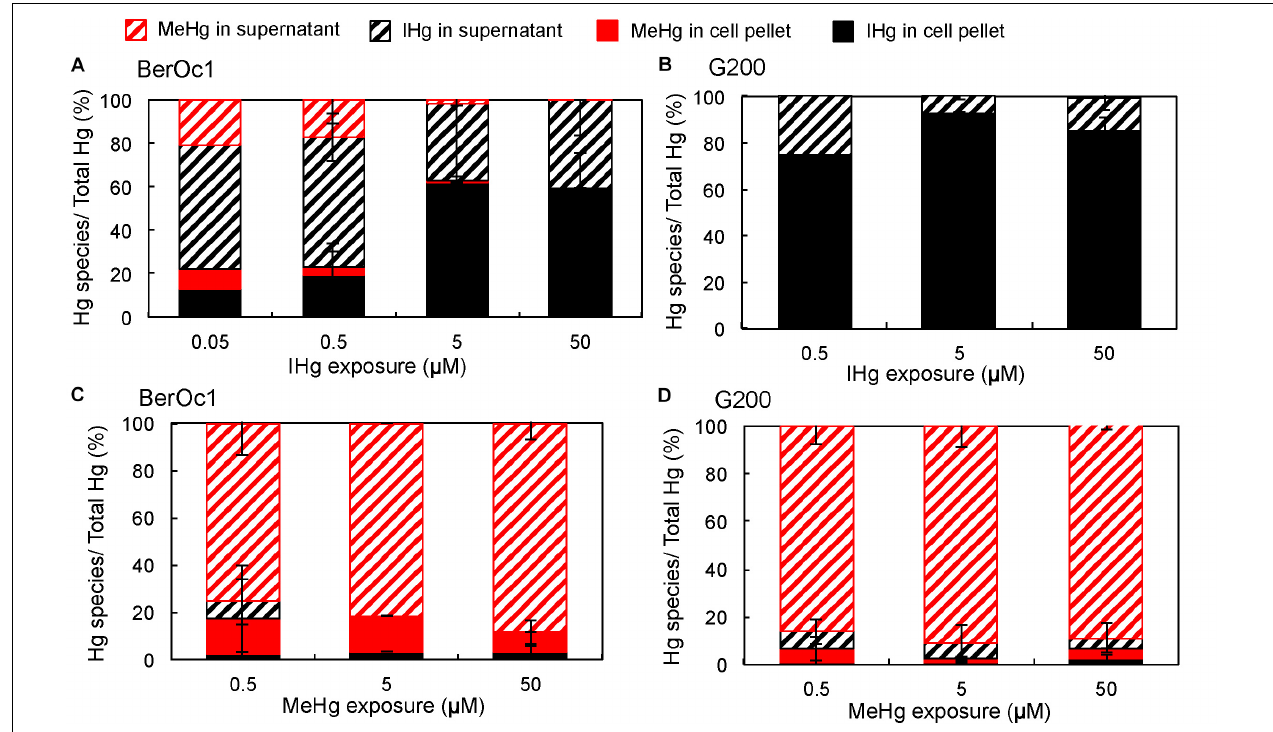
FIGURE 2 | Partitioning of IHg and MeHg (in% of total Hg) in the cell pellet and in the supernatant for BerOc1 (A,C) and G200 (B,D) exposed to various concentrations of IHg (A,B) or MeHg (B,C) . Error bars correspond to standard deviation calculated on results from two or three